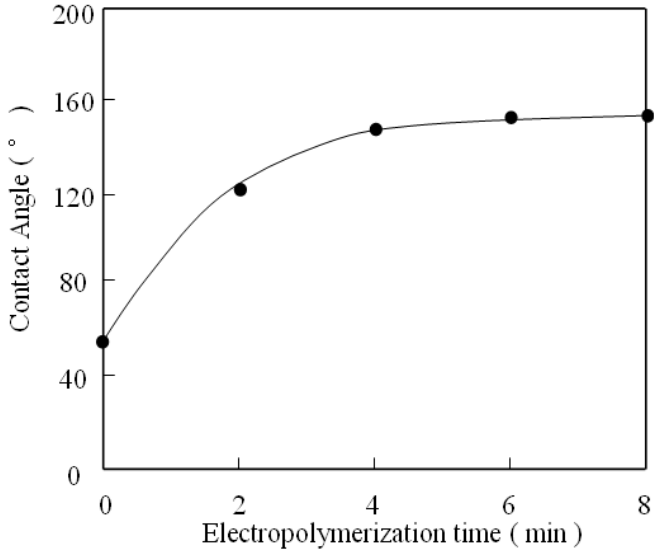
Figure 4. Effect of electrochemical polymerization time on the contact